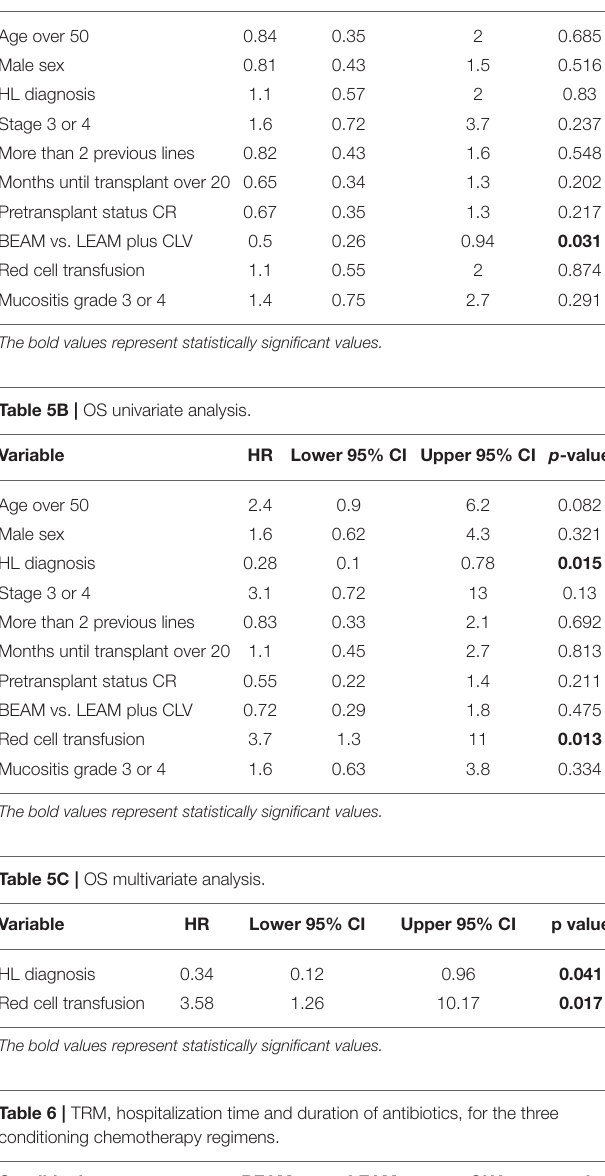
Table 5A | RFS univariate analysis.